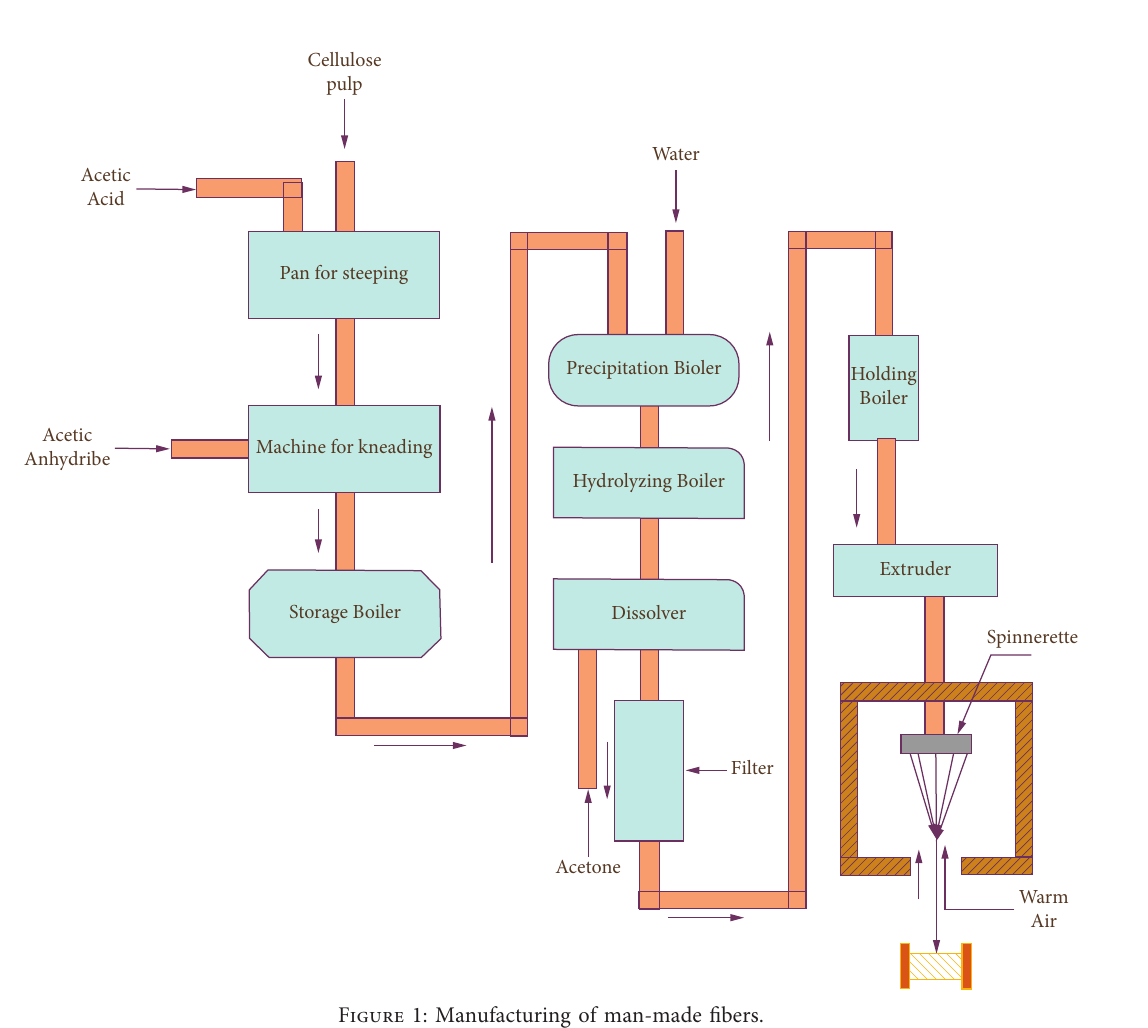
Figure 1: Manufacturing of man-made